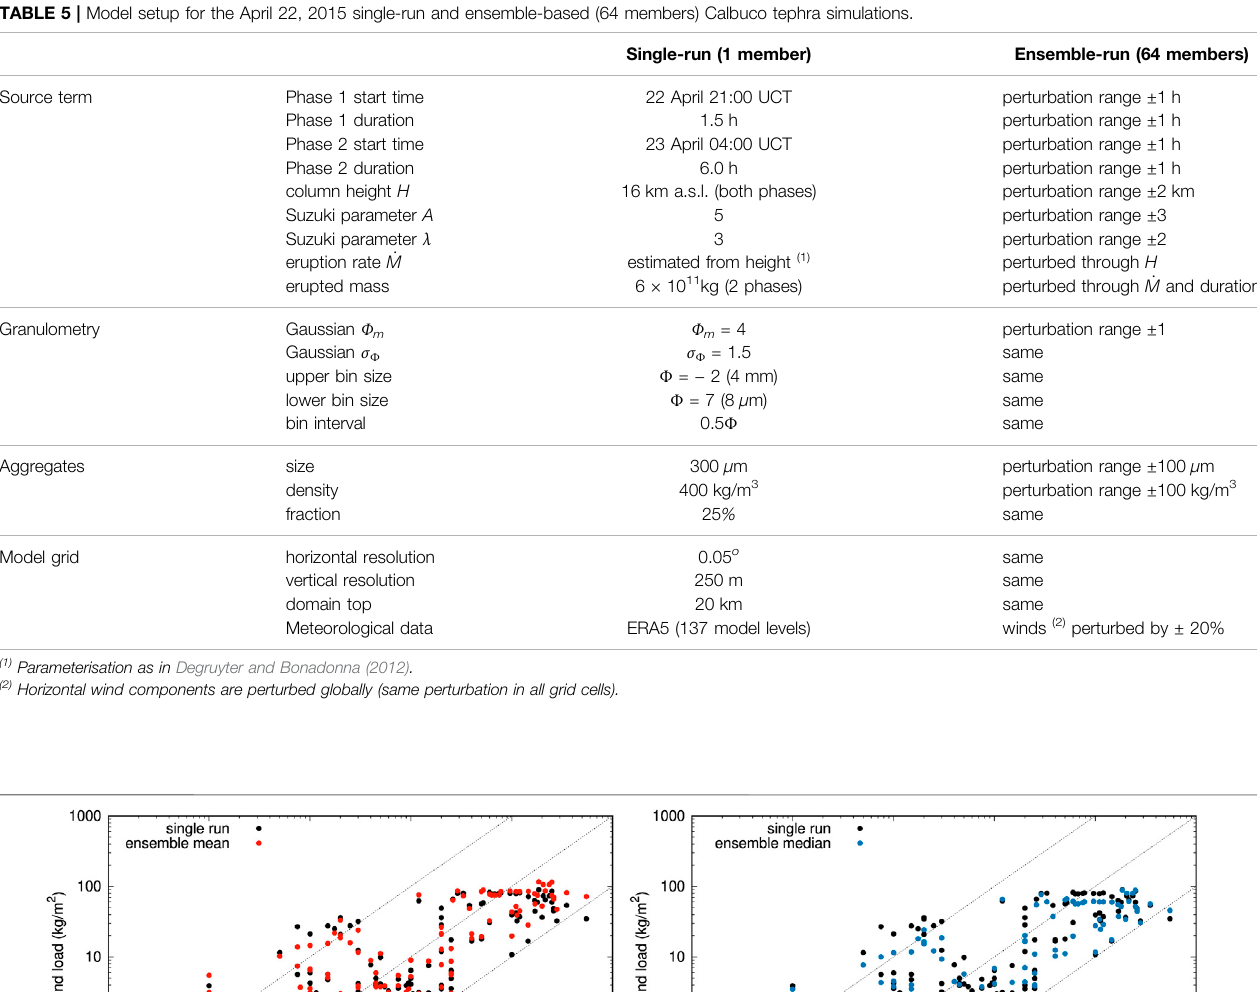
TABLE 5 | Model setup for the April 22, 2015 single-run and ensemble-based (64 members) Calbuco tephra simulations.